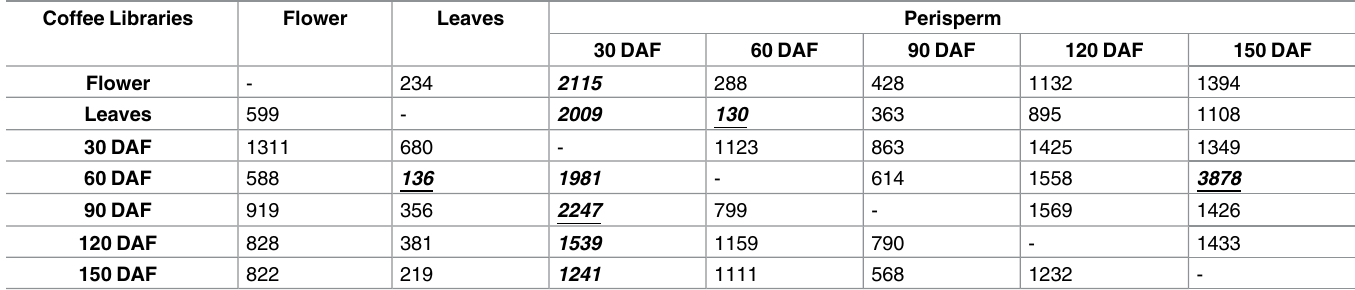
Table 3. A summary of up- and down-regulated DGEs among coffee libraries * .